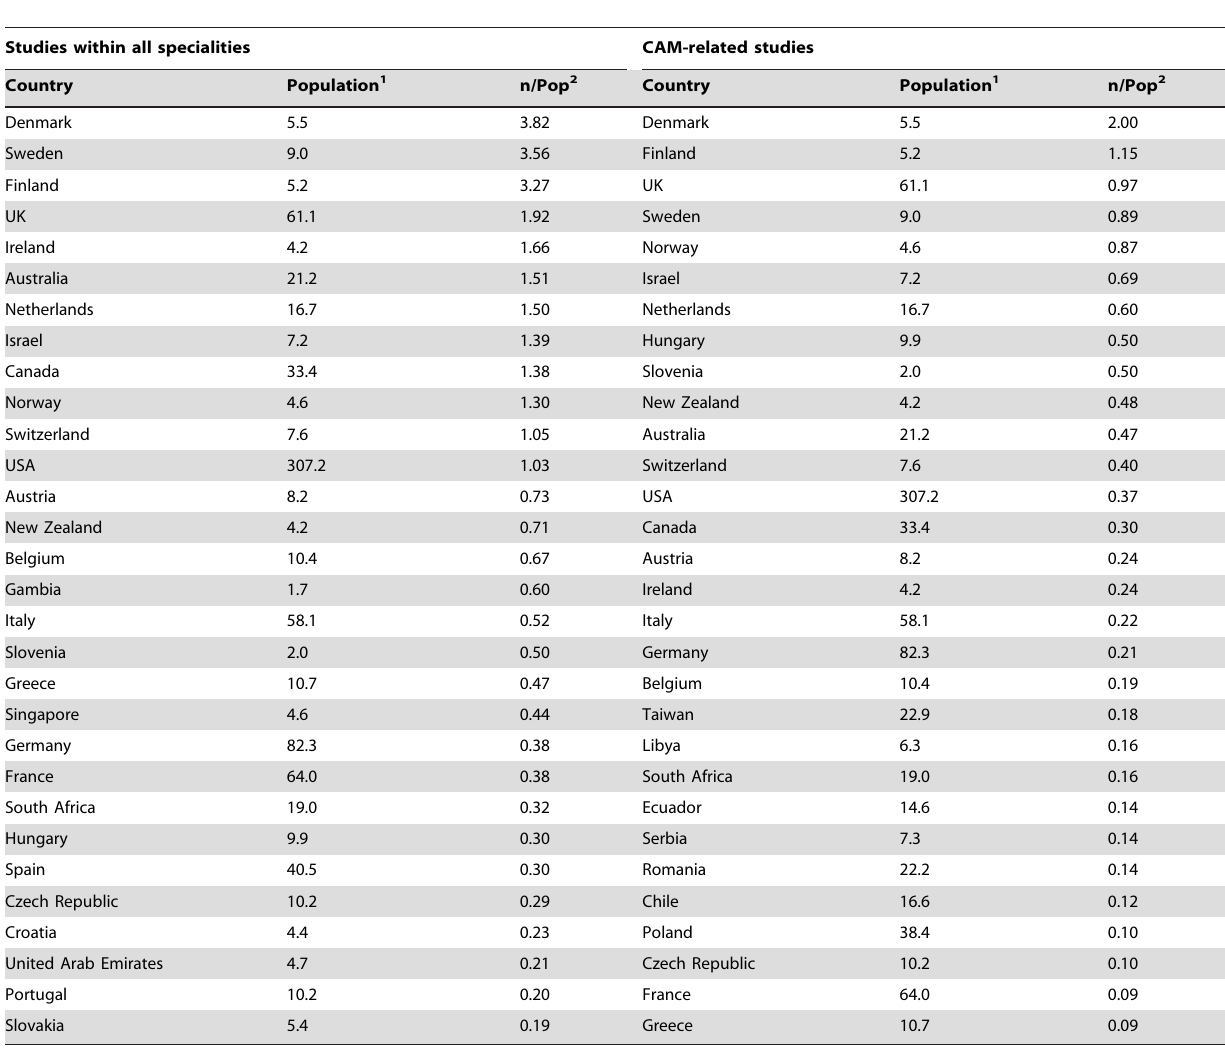
Table 2. Number of studies per million inhabitants per country within all specialities (left) and CAM-related studies (right).